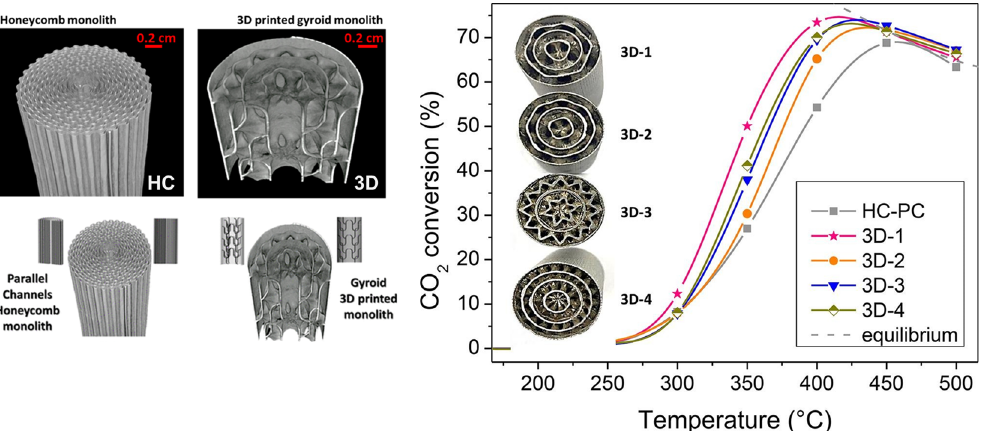
Figure 6. Comparison of the catalytic performance between conventional honeycomb monolith and different tailored 3D gyroid geometries metallic substrates on CO 2 methanation. Adapted from references [139,140]. Reprinted with permission from reference [140]. Copyright 2021 American Chemical Society.